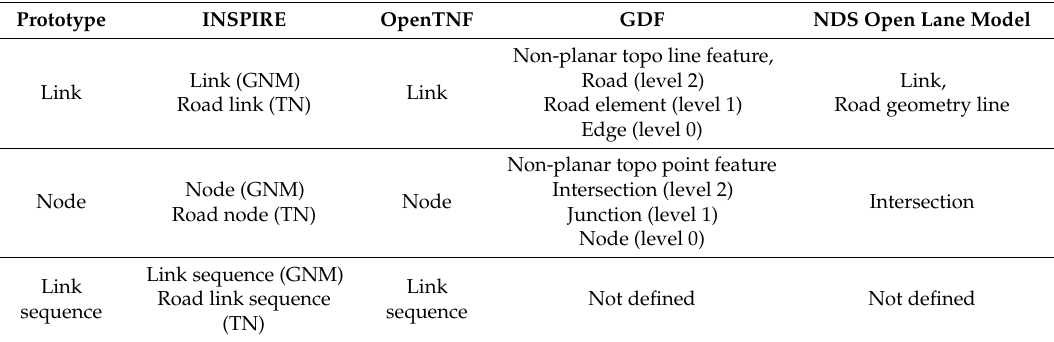
Table 6. Comparison of concepts from network